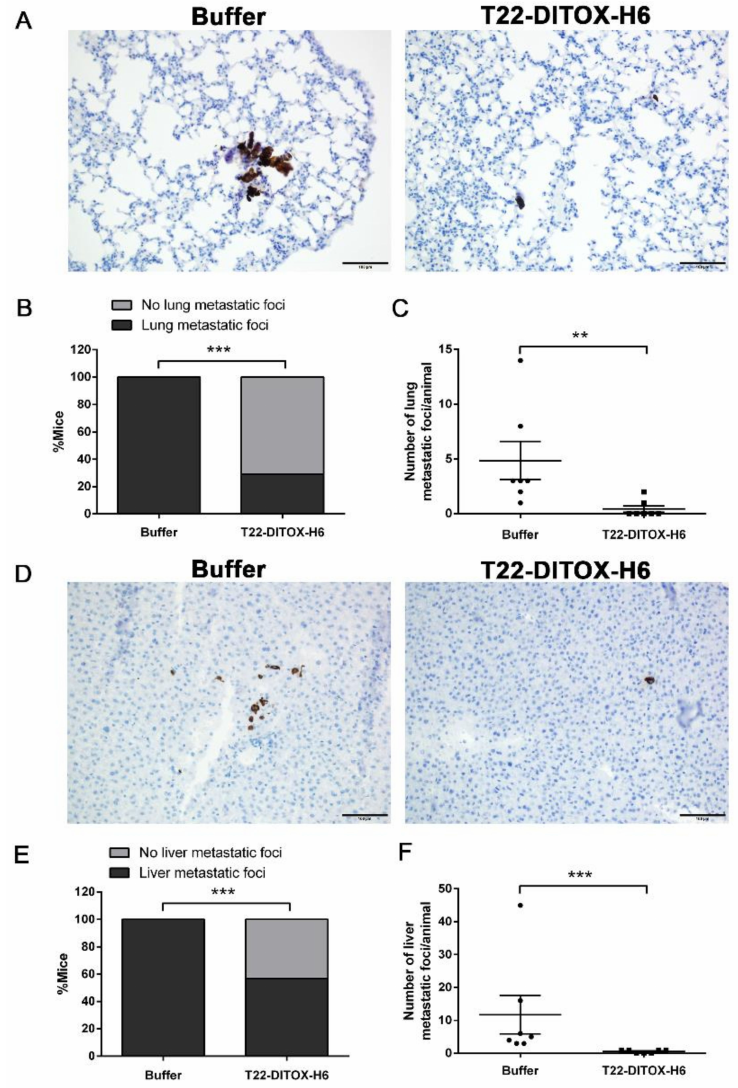
Figure 4. T22-DITOX-H6 repeated administration inhibits distant metastatic dissemination to lungs and liver in a HNSCC-disseminated mouse model. ( A ) Representative human-vimentin IHC images of lung metastatic foci in samples obtained from buffer- and nanotoxin-treated mice. Scale bars = 100 µ m. ( B ) Percentage of the animals from control and treated groups displaying lung metastases detected by human-vimentin IHC. ( C ) Quantification of the number of lung metastatic foci in each animal from the buffer- and T22-DITOX-H6-treated groups. ( D ) Human-vimentin IHC images showing the metastatic foci in the liver samples collected from control and treated mice. Scale bars = 100 µ m. ( E ) Percentage of the animals from buffer- and T22-DITOX-H6 groups presenting liver metastases detected by human-vimentin IHC. ( F ) Quantification of the number of liver metastatic foci in each animal from the buffer- and nanotoxin-treated groups. ** p < 0.01; *** p < 0.001; n = 7 per group (total animal number 14). Statistical analysis was performed by Mann–Whitney test and Fisher’s test. Error bars indicate